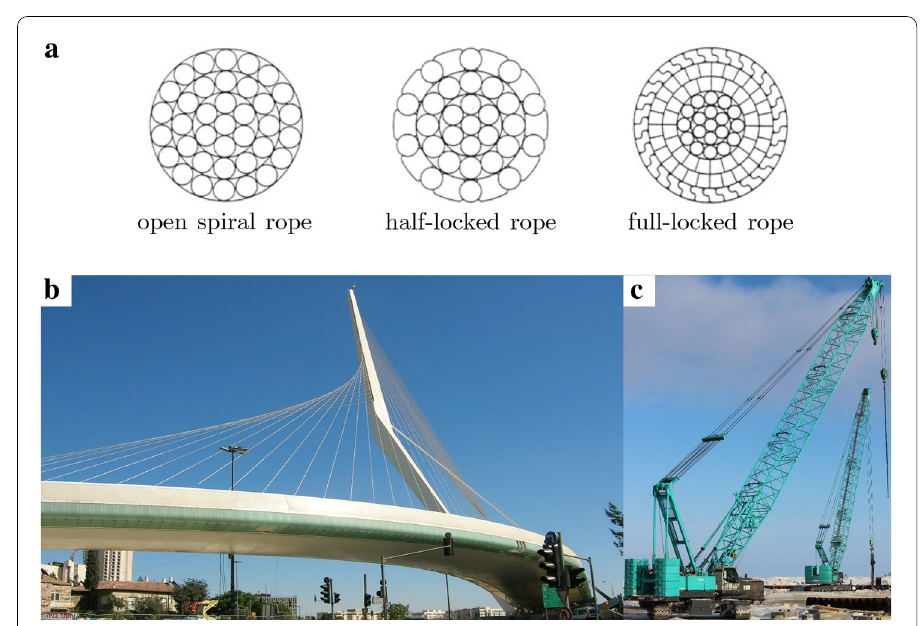
Fig. 2 a Examples of stationary ropes (adapted from [5]). b ChordsBridge , a cable-stayed bridge in Jerusalem [23]. c Kolbelco CKE1800, a crawler crane with the main boom suspended by ropes